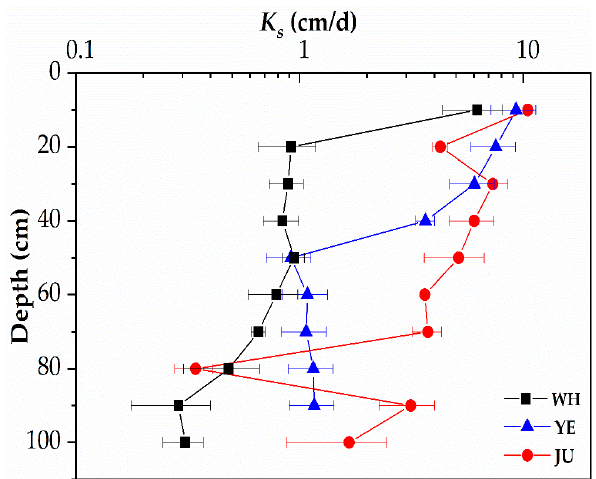
Figure 10. Saturated water conductivity ( K s ) in the WH, YE, and JU profiles.